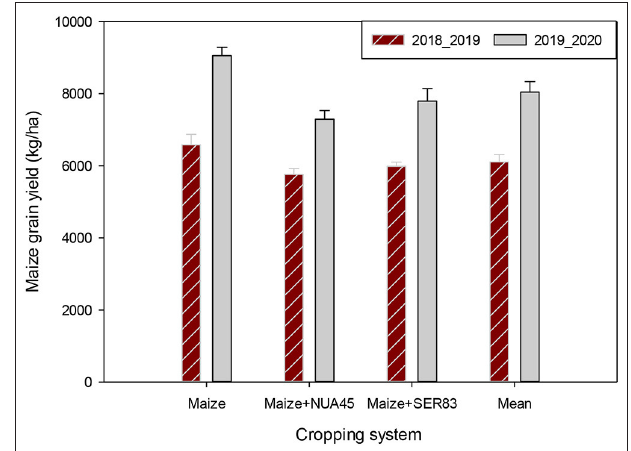
FIGURE 3 | Grain yield (kg/ha) of common bean under sole and intercropping systems with a maize variety SC672 evaluated at Chitedze and Linthipe during 2018/2019 and 2019/2020 growing